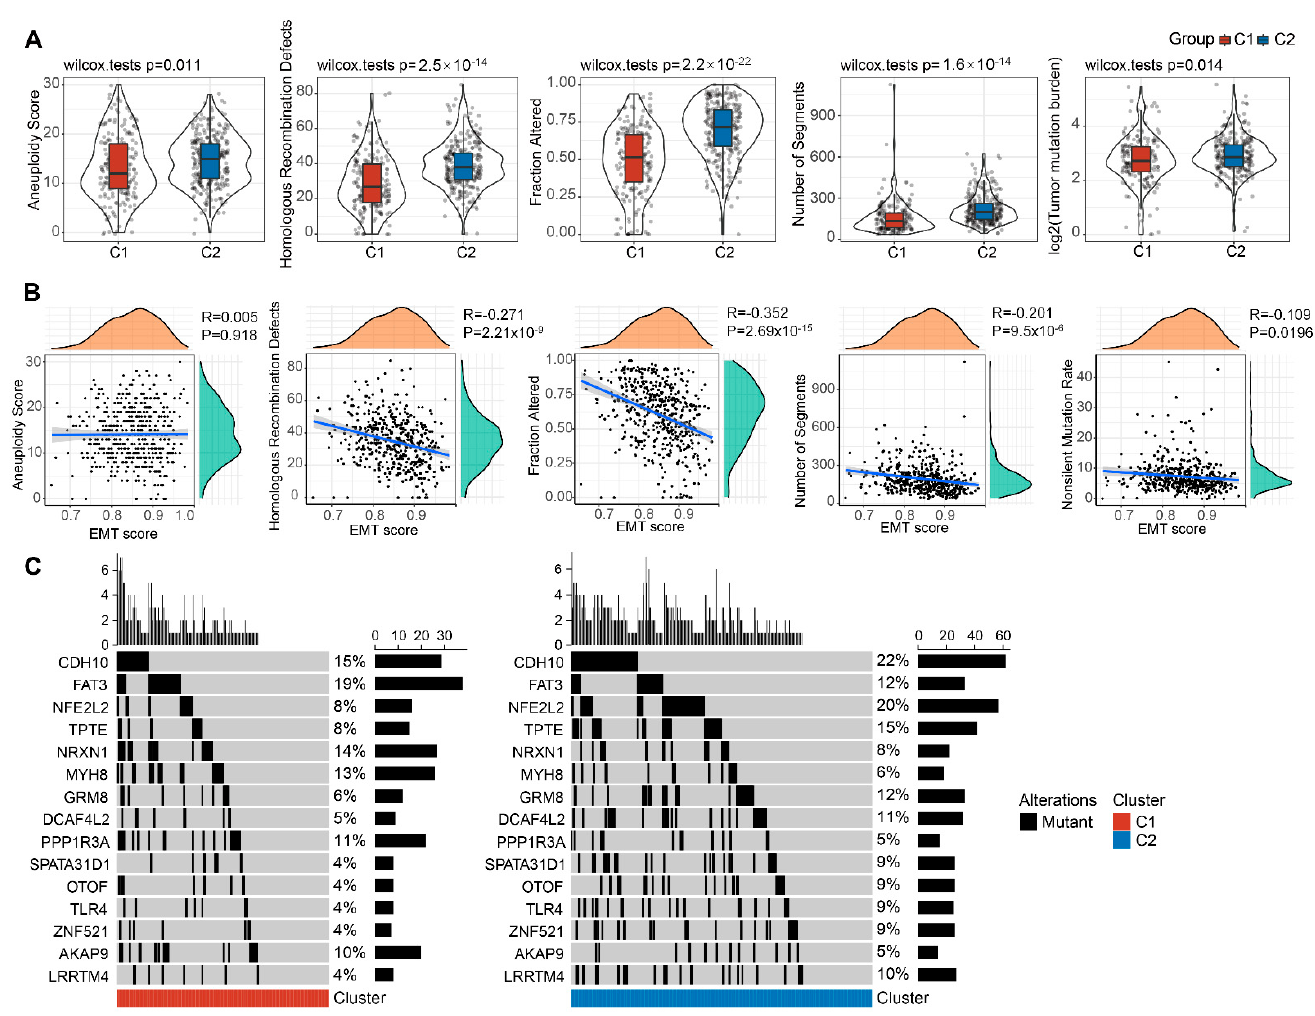
Figure 3. Genomic alterations of the molecular subtypes in TCGA cohorts. ( A ) The discrepancy of homologous recombination defects, aneuploidy score, fraction altered, number of segments and tumor mutation in the TCGA molecular subtypes. ( B ) Correlation analysis between EMT activity and homologous recombination defects, aneuploidy score, fraction altered, number of segments, and tumor mutation in TCGA cohorts. ( C ) The analysis of somatic mutations in the subtypes (Fisher’s test).